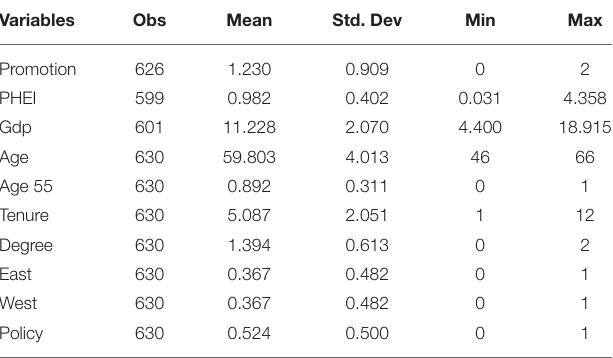
TABLE 2 | Descriptive statistics of the